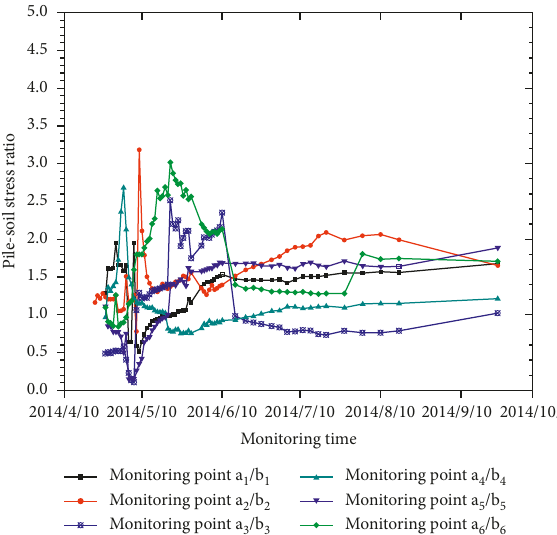
Figure 12: Variation of the pile-soil stress ratio with time.